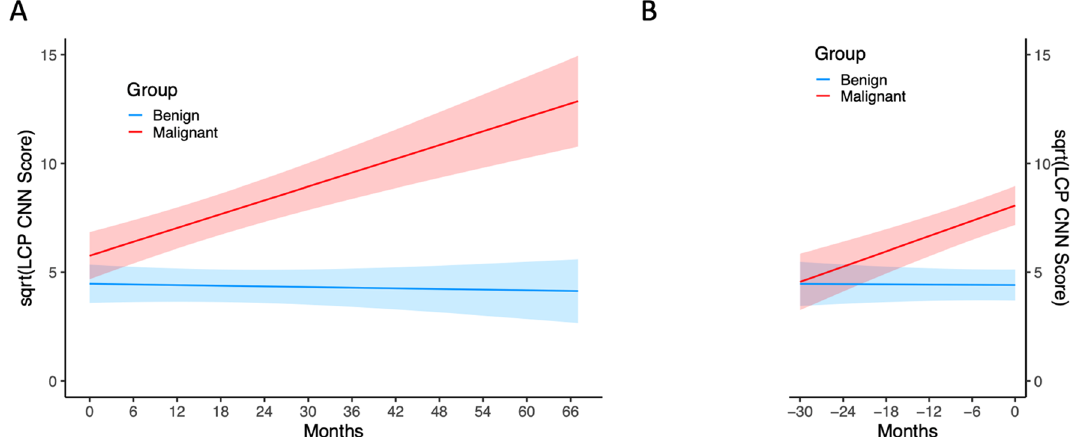
Figure 2. The predicted LCP CNN score on a square root scale overtime for benign and malignant nodules. Panel A shows the predicted LCP CNN score with time 0 representing the time of initial nodule identification. Panel B shows the predicted LCP CNN score with time 0 representing the time of final nodule